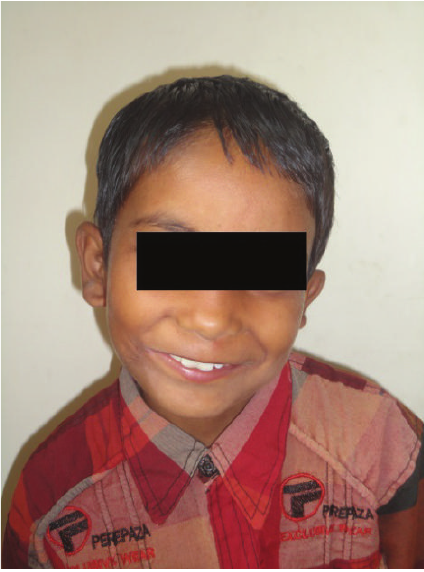
Figure 4: Postsurgery